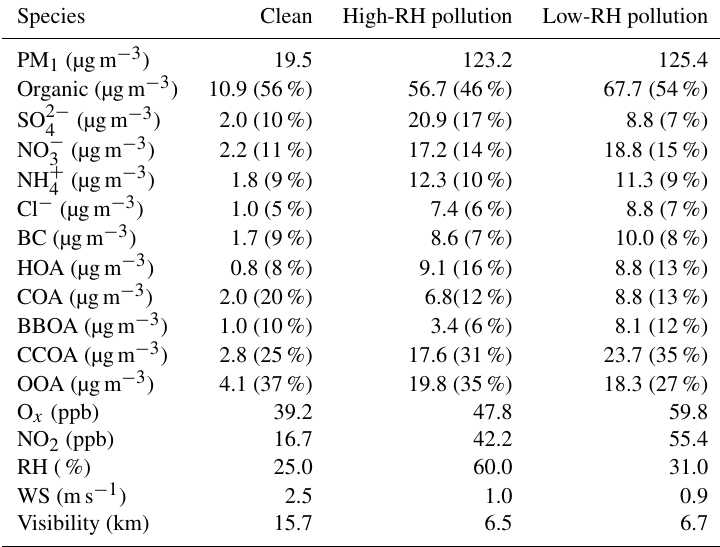
Table 1. Summary of the PM 1 composition, OA sources and meteorological conditions during different pollution